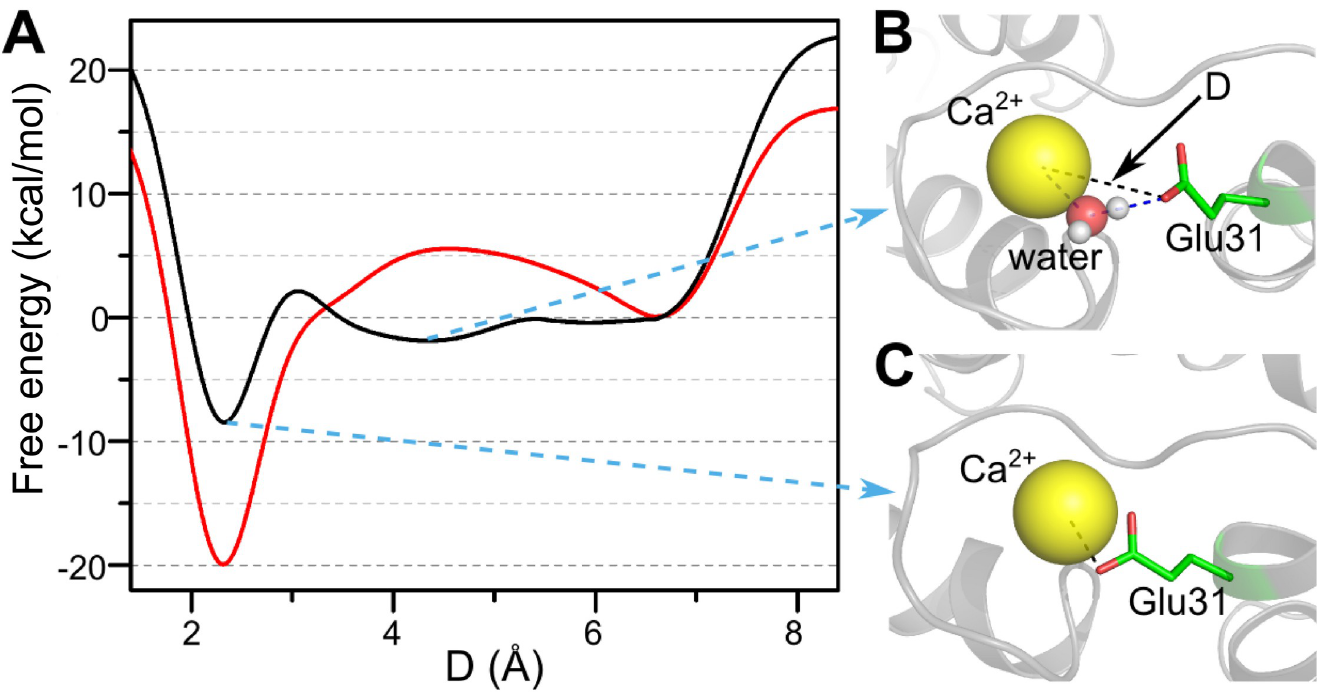
Fig 6. Free energy profiles of water bridged coordination of Glu31 side-chain oxygen atoms to the Ca 2+ . (A) Potential of mean force for the binding/unbinding process of Glu31 to Ca 2+ as a function of the minimum distance between side-chain oxygen atoms of Glu31 and Ca 2+ . The black line illustrates the results with the water molecules being realistically treated. The red line shows the results with electrostatic interactions involving the bridging water molecules being turned off. (B) The water-bridged coordination of Glu31 oxygen and Ca 2+ , where D = 4.3 Å is a local free energy minimum. (C) shows the direct coordination bond of Glu31 oxygen and the Ca 2+ , which corresponds to the most stable state at D = 2.3 Å